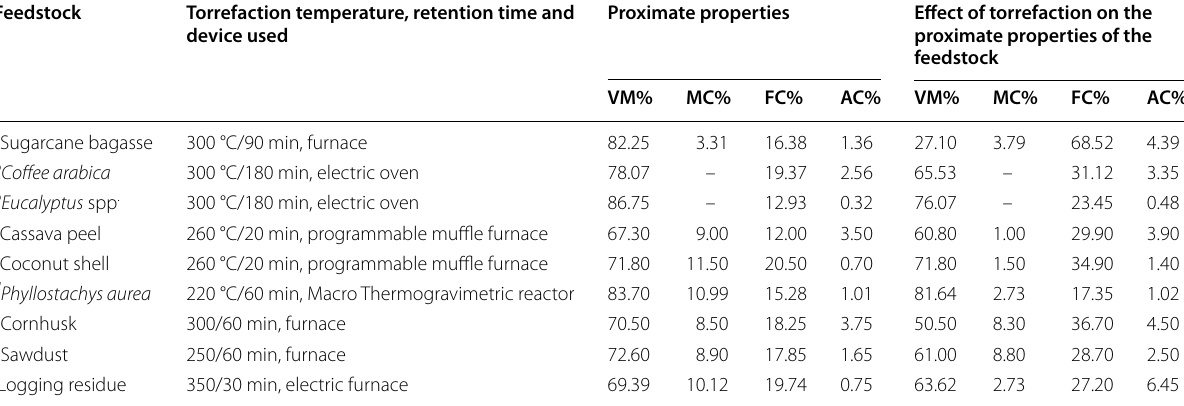
VM volatile matter, MC moisture content, FC fixed carbon, AC ash content a Nunes et al. (2021) b Portilho et al. (2020) c Ibeto et al., (2017) d Chaves et al. (2021) e Akogun and Waheed (2022)